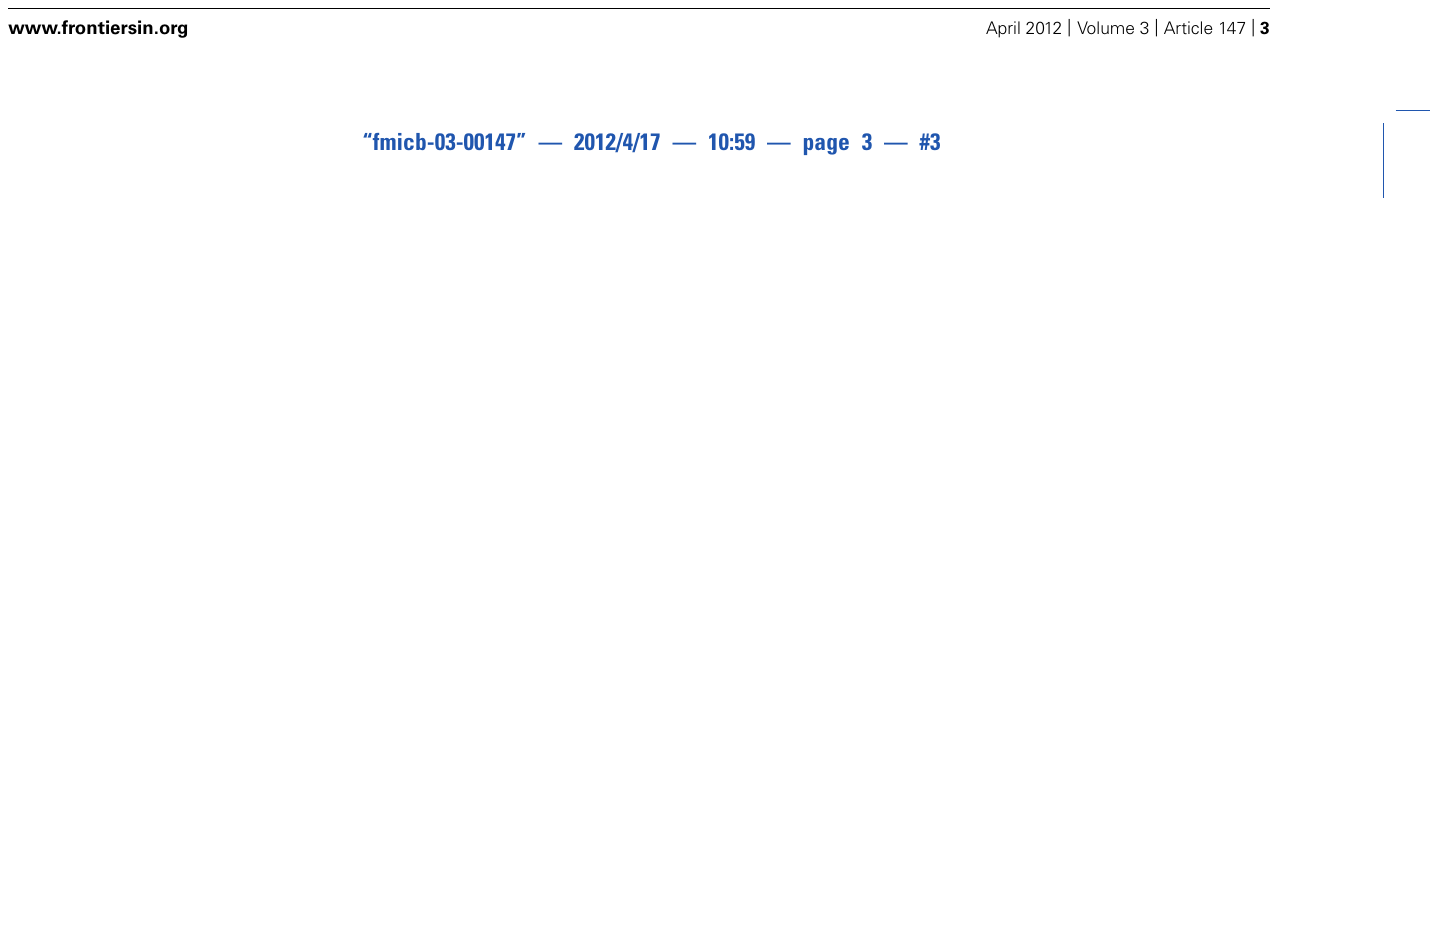
FIGURE 2 | Mechanisms for hPVR-dependent and -independent transport of PV in MNs. (A) In hPVR-Tg mice, PV is endocytosed after interacting to hPVR (Aa) . Most of the hPVR-containing vesicles are retrogradely transported in an hPVR-dependent manner with fast kinetics (Ac) . hPVR-independent endocytosis (Ab) and transport (Ae) of PV also occur.The hPVR-independent endocytosis is possibly mediated by an unidentified PV receptor expressed at neuromuscular junctions. Alternatively, hPVR-independent endocytosis may be promoted by synaptic activity in vivo . PV-containing vesicles with or without hPVR can be retrogradely transported in an hPVR-independent manner with slow kinetics